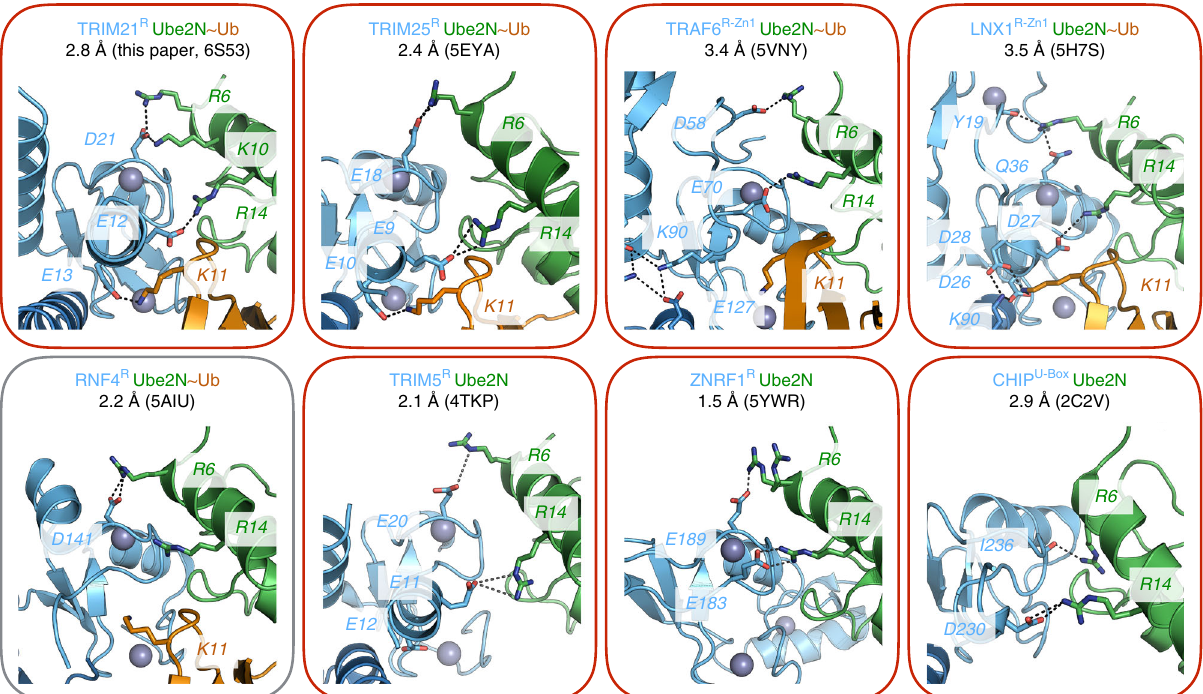
Fig. 8 The ionic anchor points are structurally conserved outside TRIM RINGs. Close-ups of RING:Ube2N(~Ub) structures. Residues equivalent to the ionic anchor points in TRIMs are labeled. Red color of the frame indicates the presence and gray color the absence of the ionic anchor points in each